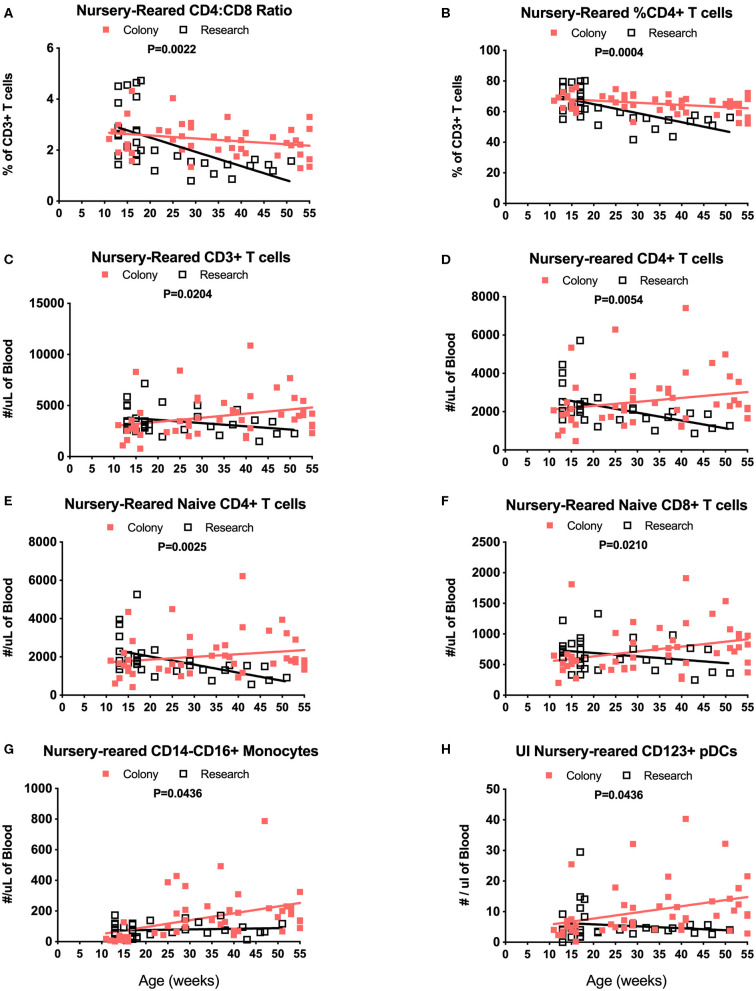
Linear regression and ANCOVA analyses of selected immunophenotyping parameters for comparison between Colony NR and Research NR animals over age during the first year of life for; CD4:CD8 ratios (A), percent of CD4+ T cells (B), number of CD3+ T cells (C), number of CD4+ T cells (D), number of naïve CD4+ T cells (E), number of naïve CD8+ T cells (F), number of non-classical monocytes (G), and number of plasmacytoid dendritic cells (pDCs) (H).